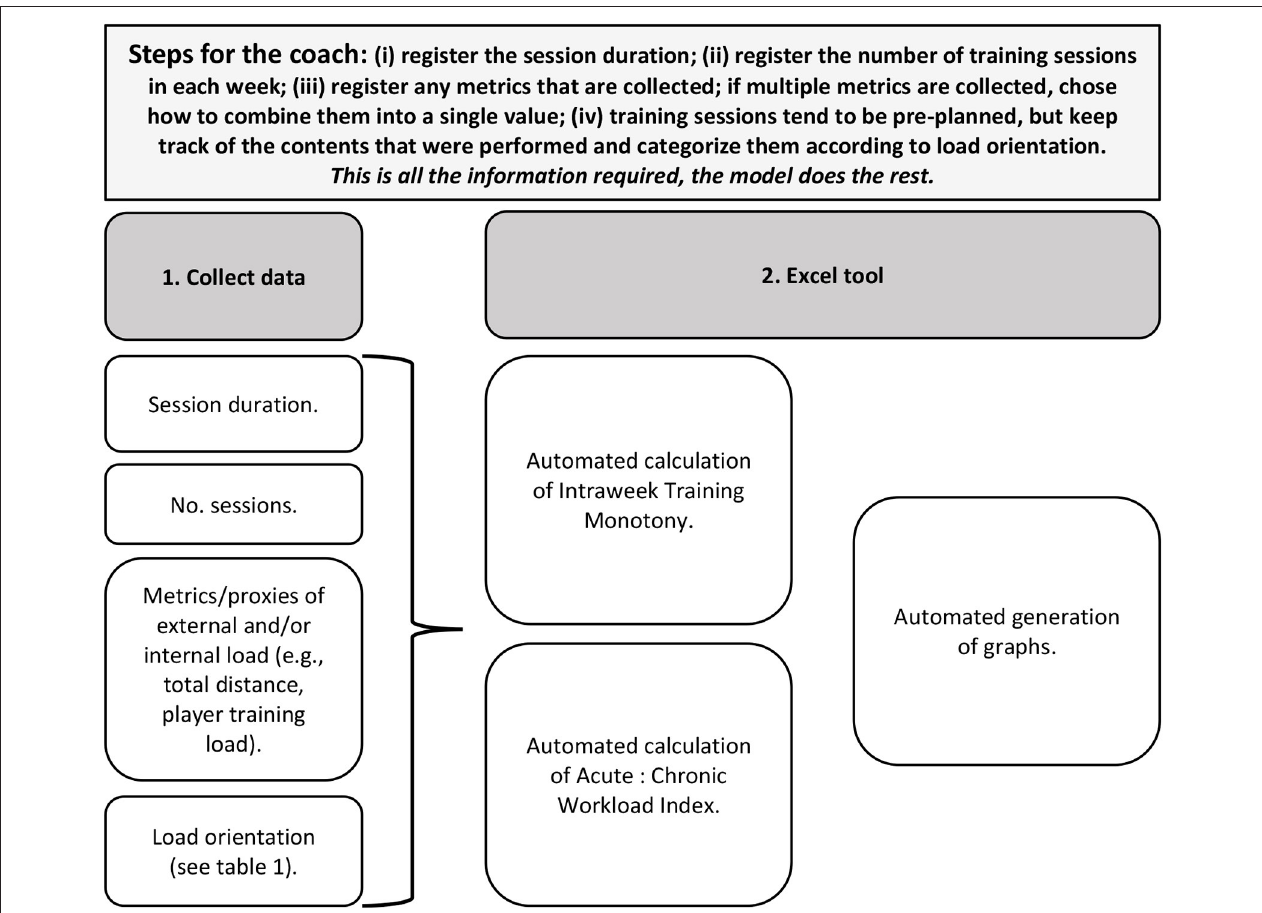
FIGURE 2 | Steps for the coaches to use the